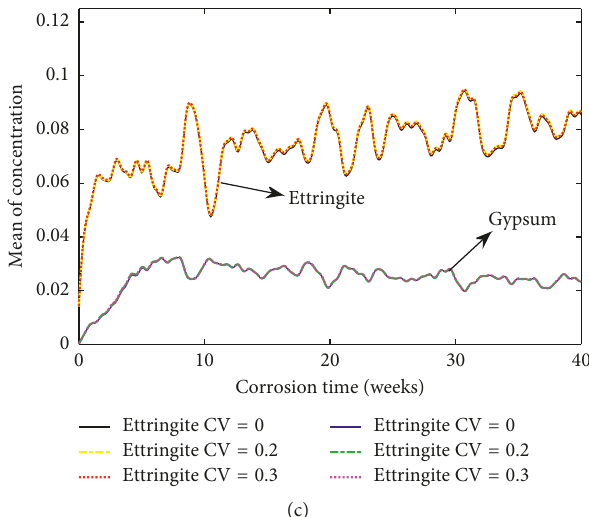
Figure 12: Concentration means of the corrosion products affected by the initial concentration variations of (a) sodium sulfate, (b) gypsum, and (c)